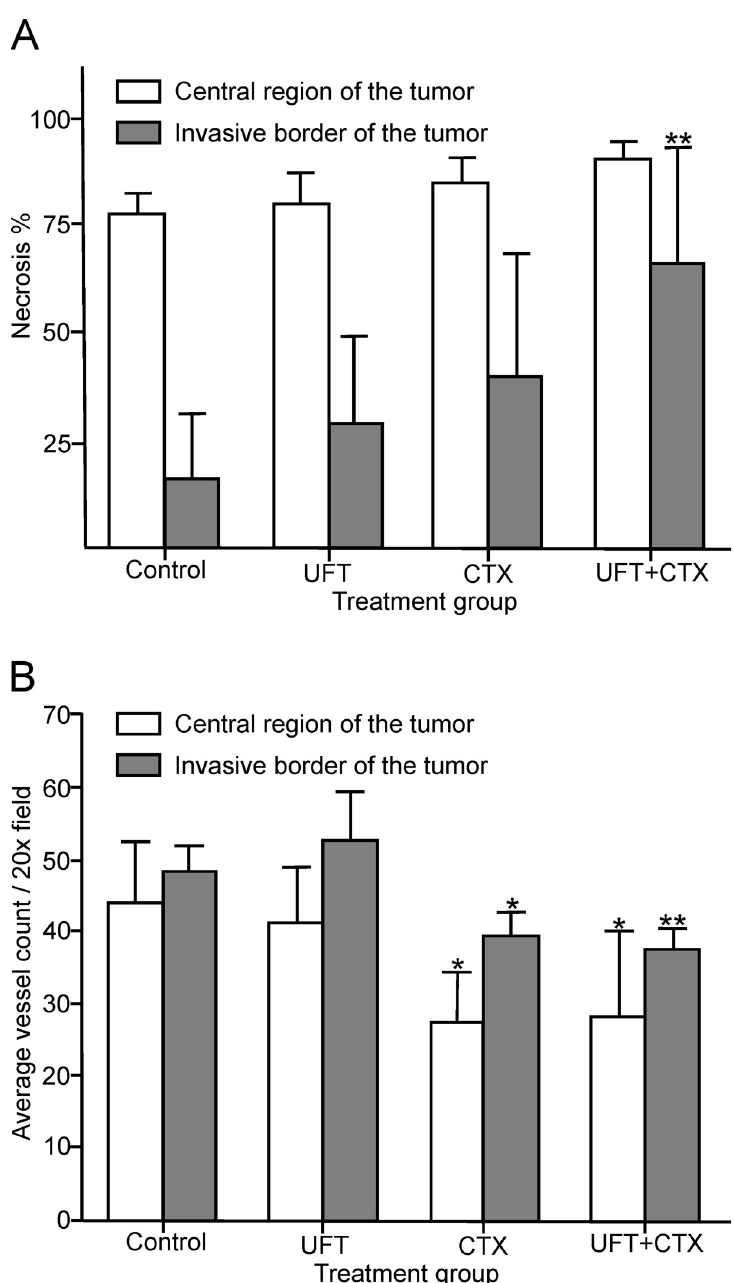
Fig 2. Tumor necrosis and vascular density are altered by the metronomic chemotherapy treatments. (A) The percentage of tumor necrosis was assessed by H&E staining in sections of the central region and the invasive border of the untreated and treated tumors. A significant increase in tumor necrosis was observed in the invasive border sections of the UFT+CTX treated tumors ( �� p < 0.01 vs. control); significance was analyzed by one-way ANOVA with Dunnett’s post-test. (B) Effect of the different treatments on vascular density as determined by double CD31/VEGR2 immunofluorescence labelling. The average vessel count of seven fields per tumor (x20 magnification), from the central region and the invasive border is presented. A significant reduction in vascular density was observed in the CTX ( � p < 0.05 vs. control) and the UFT+CTX ( �� p < 0.01 vs. control) groups; significance was analyzed by one-way ANOVA with Dunnett’s